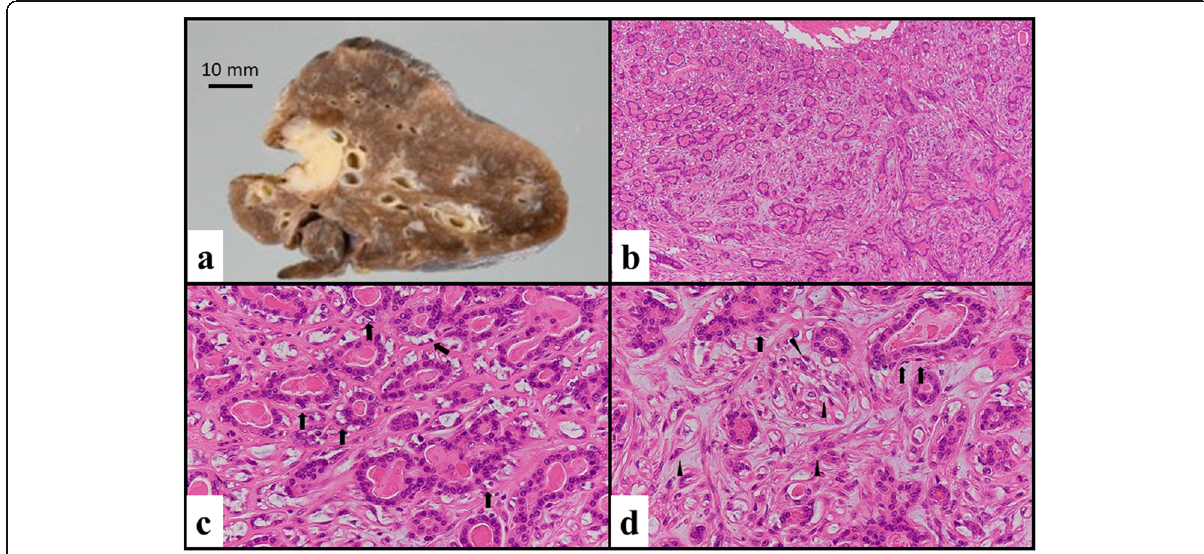
Fig. 2 Macroscopic and microscopic findings. a Cut surface of the surgical specimen. The tumor size was 2.7 × 1.9 × 1.8 cm, whitish – yellow to gray, shiny and well-demarcated. b The tumor consisted of duct-like structures and polygonal and spindle cell features. c The duct-like structures comprised two distinct cell layers. The inner-layer cells were composed of cuboidal cells with eosinophilic cytoplasm and round nuclei, and the outer-layer cells (black arrow) were composed of cells with clear cytoplasm and oval-to-fusiform nuclei. d The polygonal and spindle cells (black arrow head) were similar to the outer-layer cells (black arrow) and had clear